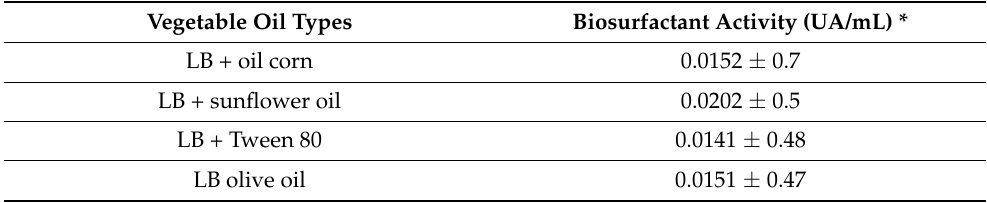
Table 1. Various vegetable oil effects on production of biosurfactants measured as UA/mL.